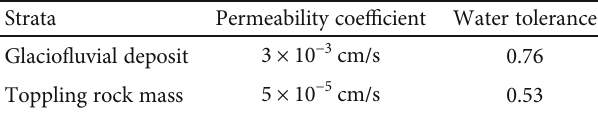
Table 1: Permeability coe ffi cients for the geomaterials.